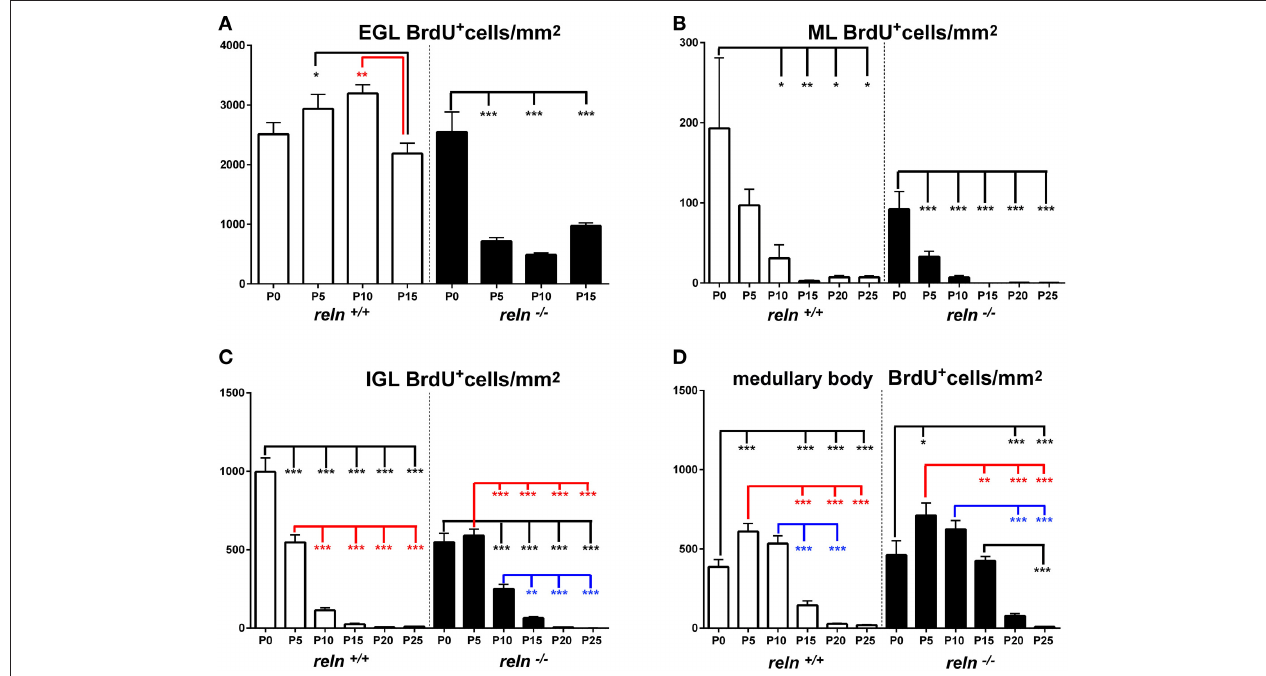
FIGURE 8 | Comparison of ApoCD within genotypes. Cortical layers (A–C) , medullary body (D) . EGL, external granular layer; ML, molecular layer; P, postnatal age. One-way ANOVA with multiple comparisons; error bars indicate SEM; *** P < 0.001; ** P < 0.01; * P < 0.05.